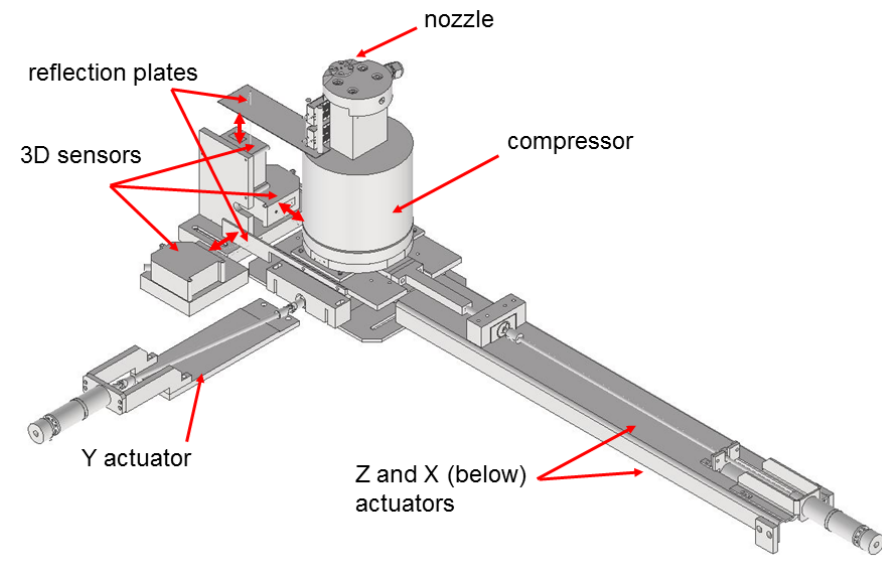
Figure 16. Adjustment system with the